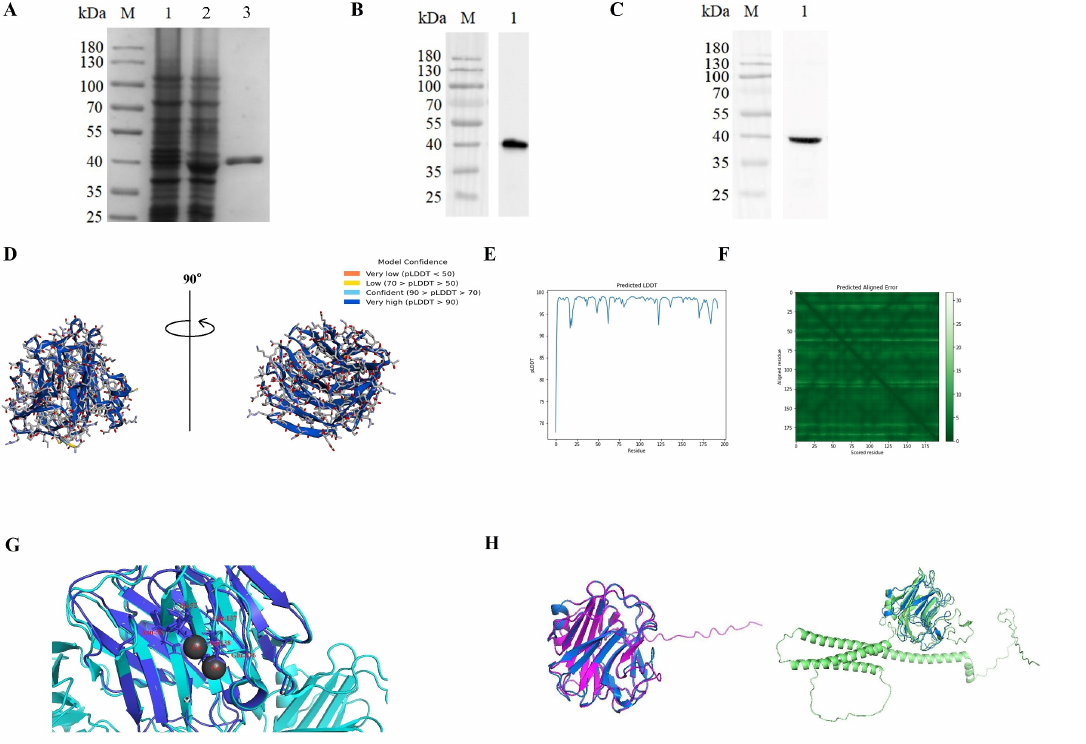
Figure 3. Purification of (r)OnSAP and Western blot analysis. ( A ) Lane M, markers; Lane 1, the bacteria liquid without IPTG induction; Lane 2, bacteria liquid was induced with 1 mM IPTG at 37 ◦ C for 6 h; Lane 3, purified (r)OnSAP fusion protein. ( B , C ) Western blot analysis of (r)OnSAP using anti-His tag mouse monoclonal antibody or polyclonal mouse anti-(r)OnSAP antibody as the primary antibody. ( D ) Tridimensional structure of OnSAP predicted by AlphaFold 2.0. ( E ) pLDDT of OnSAP remained above 90 at the start of the prediction. ( F ) PAE stayed below 10. ( G ) The similarity between OnSAP (blue) and humans SAP (sky-blue) monomer. The roots’ mean square displacement (RMSD) is 0.942 computed by Pymol 2.5. The calcium-binding sites were labeled in red words. ( H ) Similarity between OnSAP and OnCRP (pink)/OnPTX3 (green), which are also predicted by AlphaFold 2.0. The RMSD is 0.33 and 1.528.